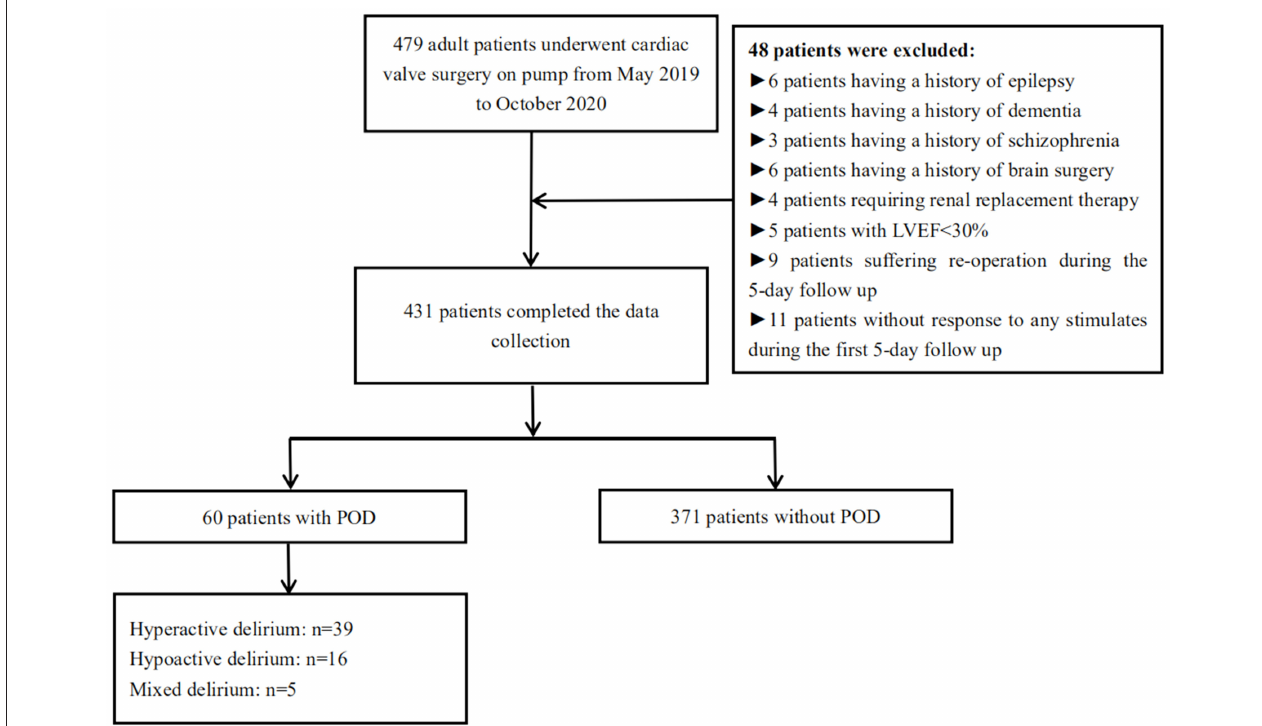
FIGURE 1 | The flow chart of screening cases and grouping for this retrospective case-control study.